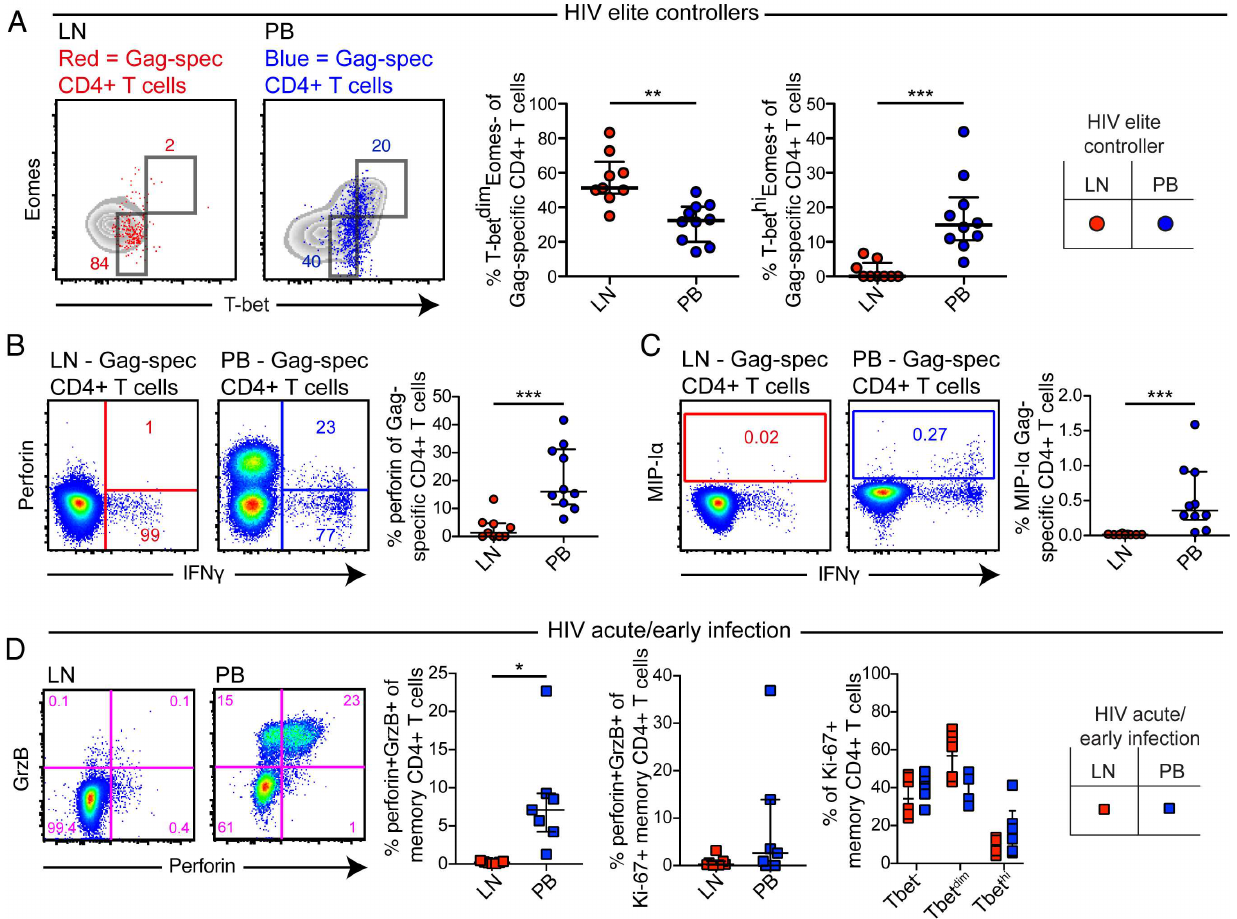
Fig 5. Expression of effector molecules by Gag-specific CD4+ T cells from HIV elite controller LNs and blood. (A) Flow cytometry plots (HIV elite controllers) illustrating the distribution of LN (red) and PB (blue) IFN γ + Gag-specific CD4+ T cell responses between the T-bet dim Eomes- and T- bet hi Eomes+ compartment. Corresponding scatterplots showing the frequencies of T-bet dim Eomes- (left) and T-bet hi Eomes+ (right) cells of Gag-specific CD4+ T cells between LN and PB for HIV elite controllers. Flow plots (HIV elite controllers) of IFN γ + Gag-specific CD4+ T cell response from LN and PB in relation to (B) perforin and (C) MIP-1 α expression. Graphs represent the frequency of (B) perforin+ and (C) MIP-1 α + Gag-specific CD4+ T cells between LN and PB. (D) Flow plots and graphs demonstrating the expression pattern of perforin+Granzyme B+ memory CD4+ T cells in acute/early seroconverters (left graph). Right graphs show the frequency perforin+Granzyme B+ or T-bet expression out of total memory Ki-67+ CD4+ T cells. Median and IQR are shown for all scatter plots. Mann-Whitney tests were performed to compare differences between groups; (cid:3) P < 0.05, (cid:3)(cid:3) P < 0.01 and (cid:3)(cid:3)(cid:3) P < 0.001. All data-points are derived from the North-American